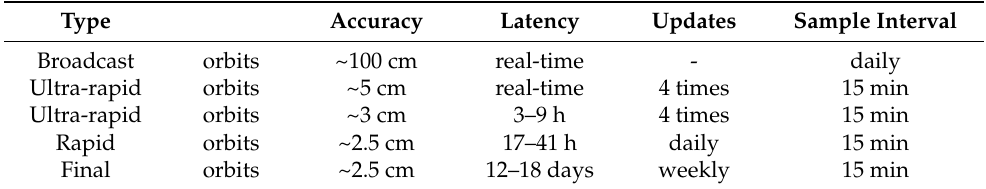
Table 1. Accuracy and latency of each IGS orbit